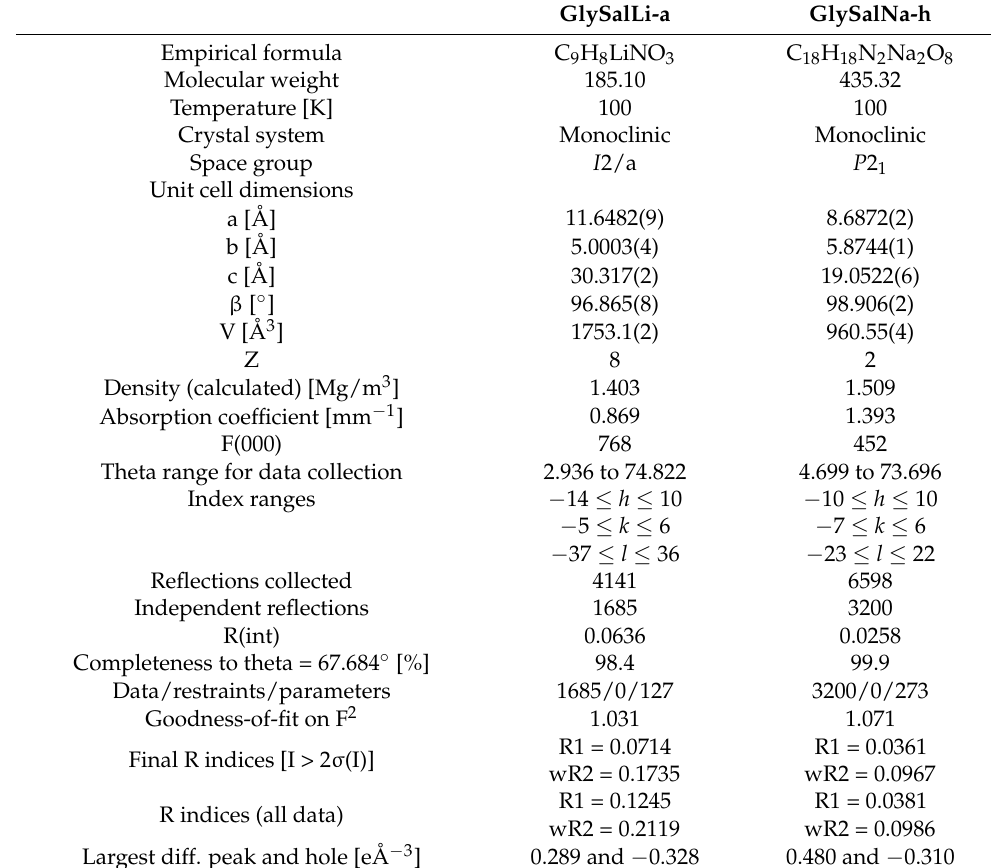
Figure 1. X-ray crystal structures of the asymmetric units of GlySalLi-a and GlySalN-h showing the numbering schemes. Displacement ellipsoids are shown at 50% probability level. Table 1. Crystallographic information concerning GlySalLi-a and GlySalNa-h structures.